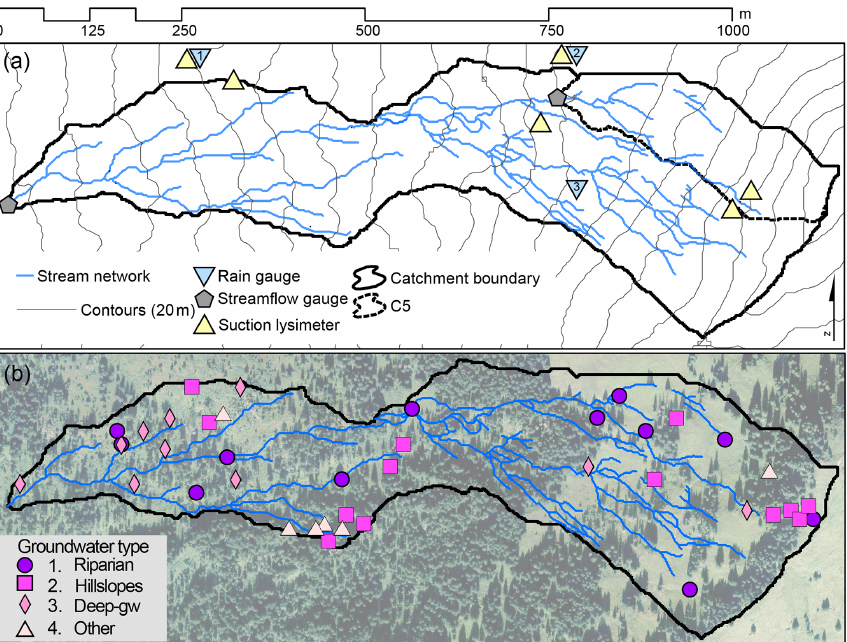
Figure 1. Maps of the Studibach catchment with (a) the stream network (blue lines), stream gauges (grey pentagons), rain gauges (blue triangles; 1–3) and suction lysimeters (yellow triangles), 20m contour lines (grey), and the boundary of the catchment (black). C5 sub- catchment (broken lines) and (b) location of the wells, colour-coded by groundwater type as follows: (1) riparian wells; (2) hillslope wells; (3) “deep” groundwater wells; and (4) wells with high magnesium and sulfate concentrations (based on Kiewiet et al.,